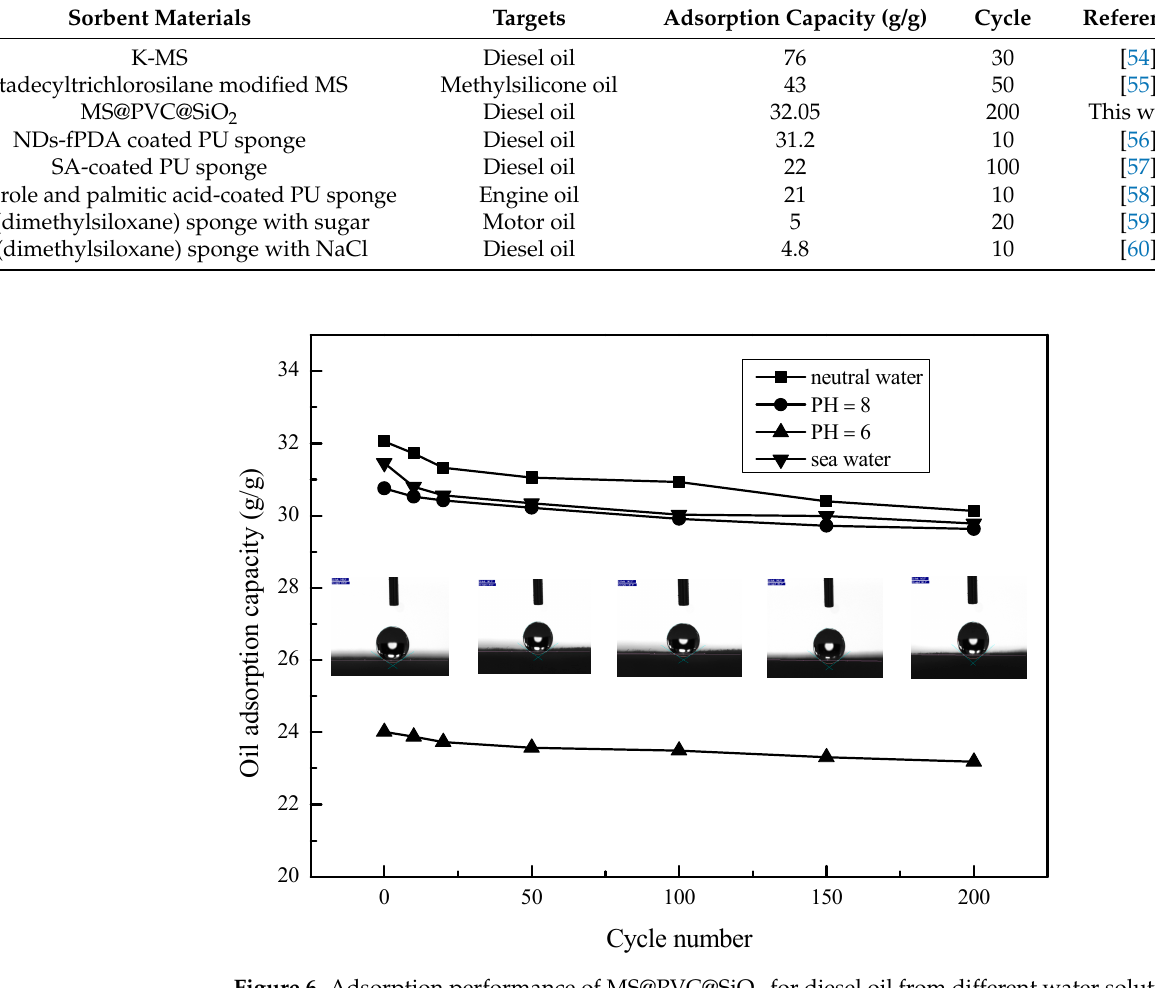
Table 3. Summary of the adsorption capacities of oils by various sponge-based adsorbents.